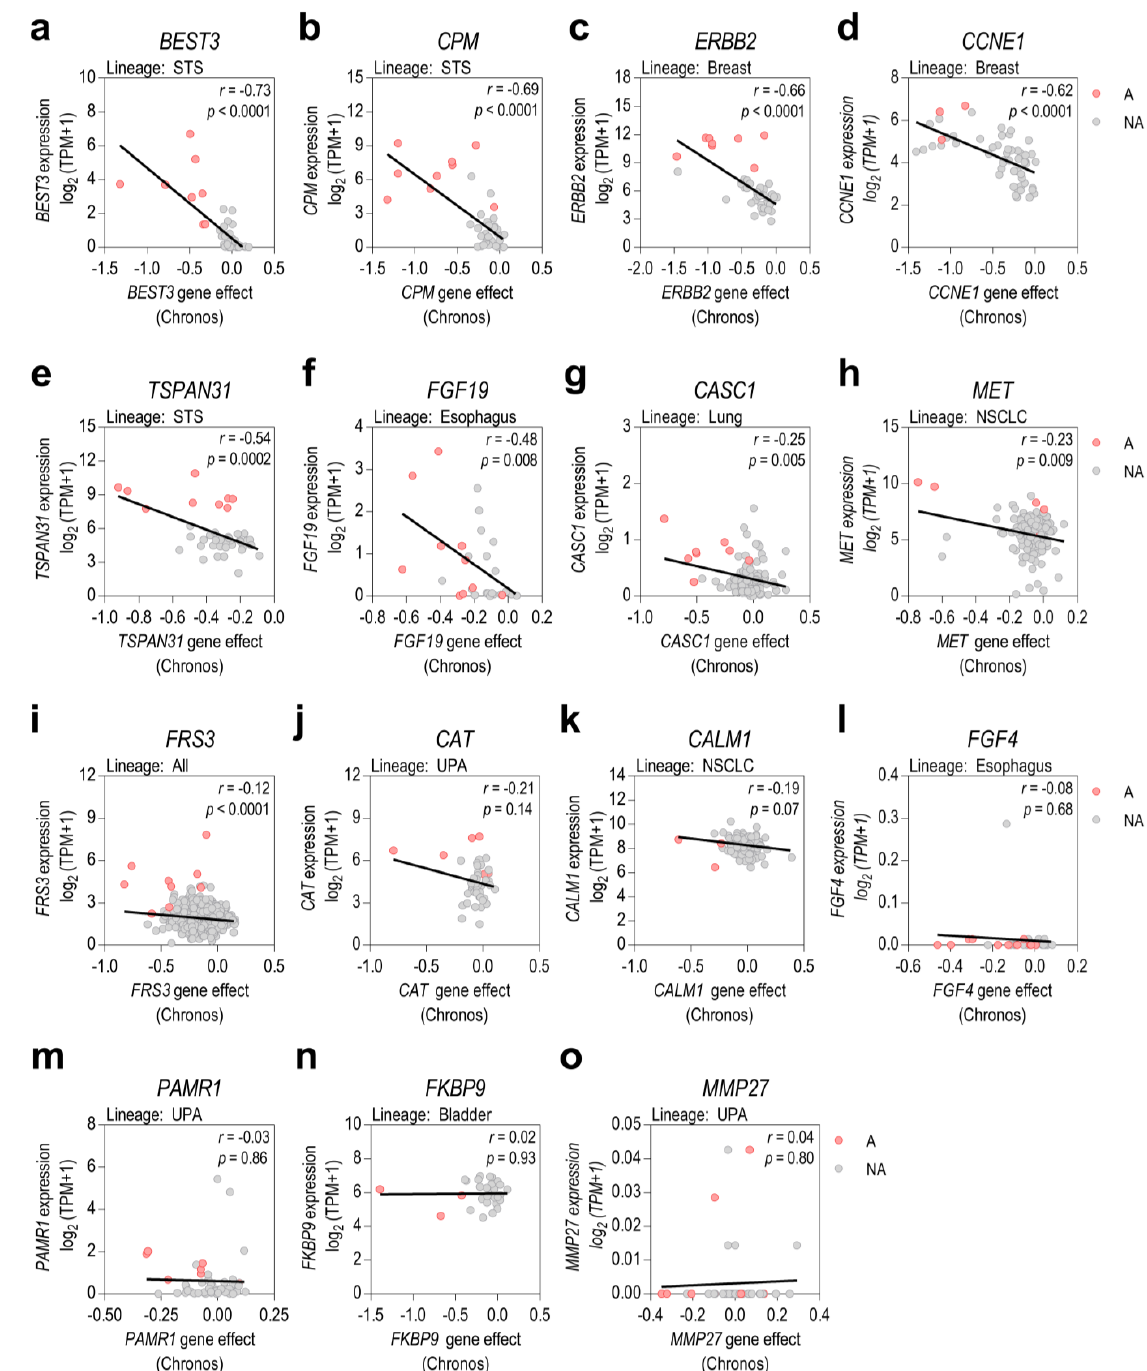
( c – r ) Differences in gene effects of the prioritized genes between amplified (A, red dots) and non- amplified (NA, grey dots) cell lines from specific tumor types. Results are shown for the following